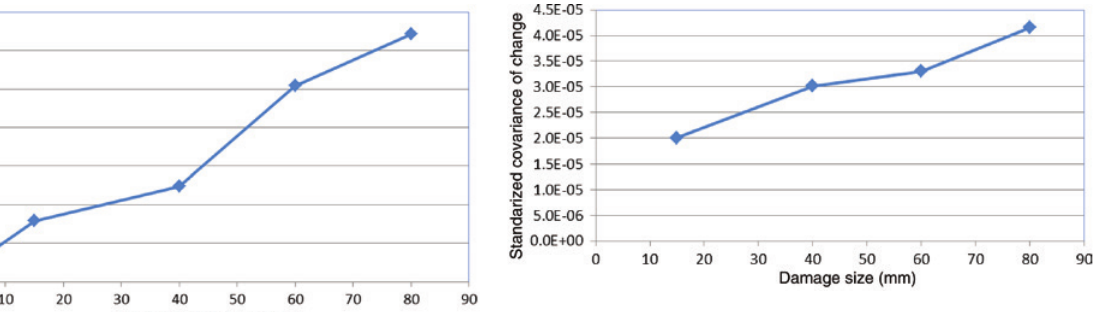
Figure 15: Covariance of energy change for full section. Table 5: Covariance of energy